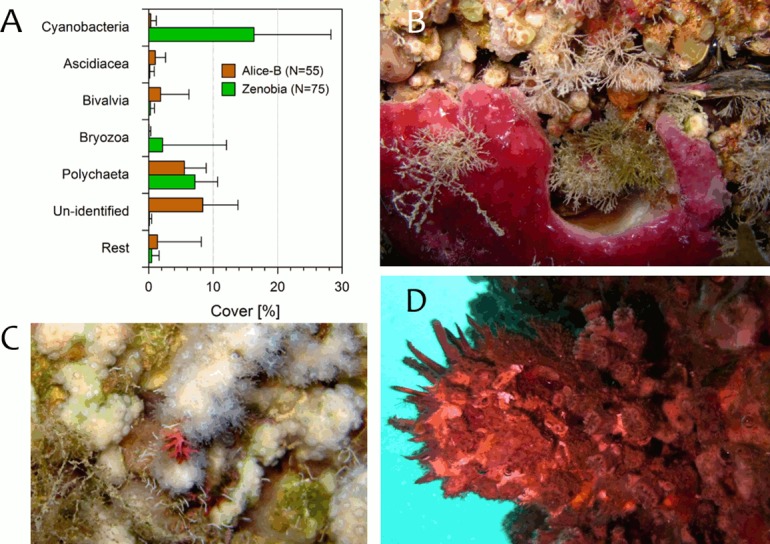
Benthic category defined as “Other” in the cover analysis of the Zenobia and Alice-B shipwrecks.A) Percentage (mean + SD) cover of subcategories that pooled together comprise “Other”; Rest = taxonomic groups that individually contributed little to the general category (e.g. foraminifers, brachiopods, hydrozoans, zoanthids, sessile crustaceans). B) Bryozoan Caberea sp. and an un-identified cyclostome; Zenobia, 26m depth. C) Foraminifer Miniacina miniacea; Zenobia 29m depth. D) Bivalve Spondylus spinosus fouled by corals (Phyllangia mouchezii, Madracis pharensis); Alice-B, 30m depth.